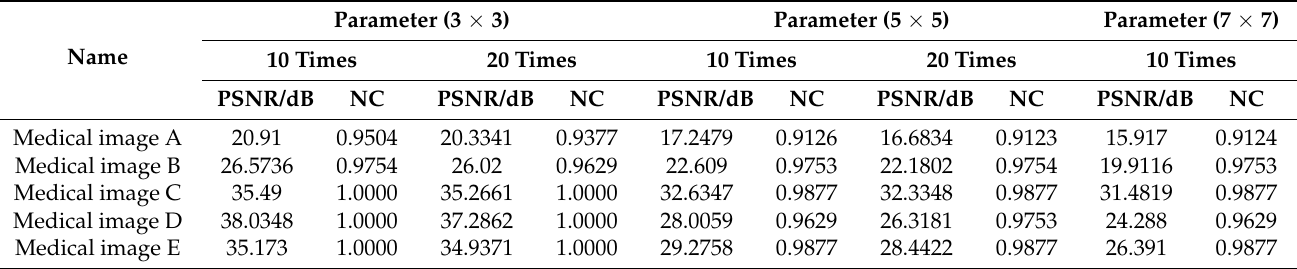
Table 3. The result under median filter